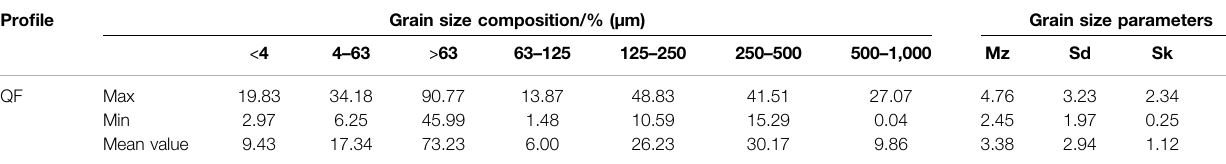
TABLE 5 | Grain size composition and Grain size parameters of QF pro fi le.